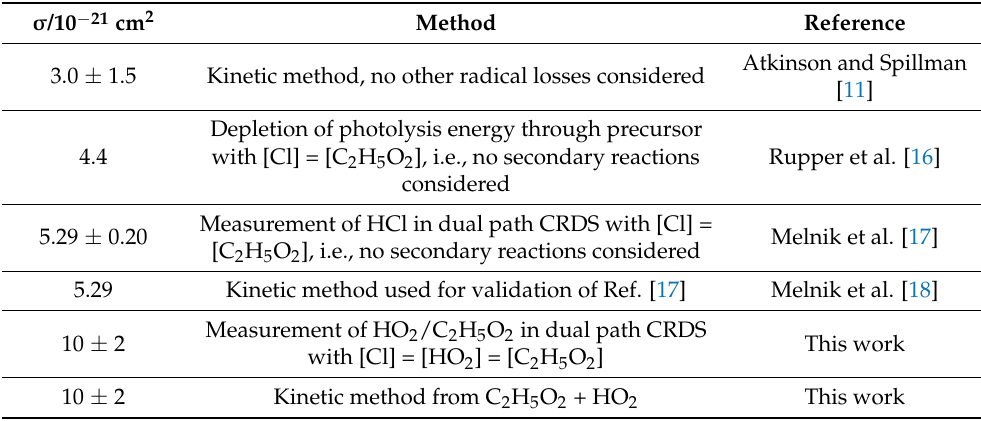
Table 1. Summary of the C 2 H 5 O 2 absorption cross-section at 7596 cm − 1.